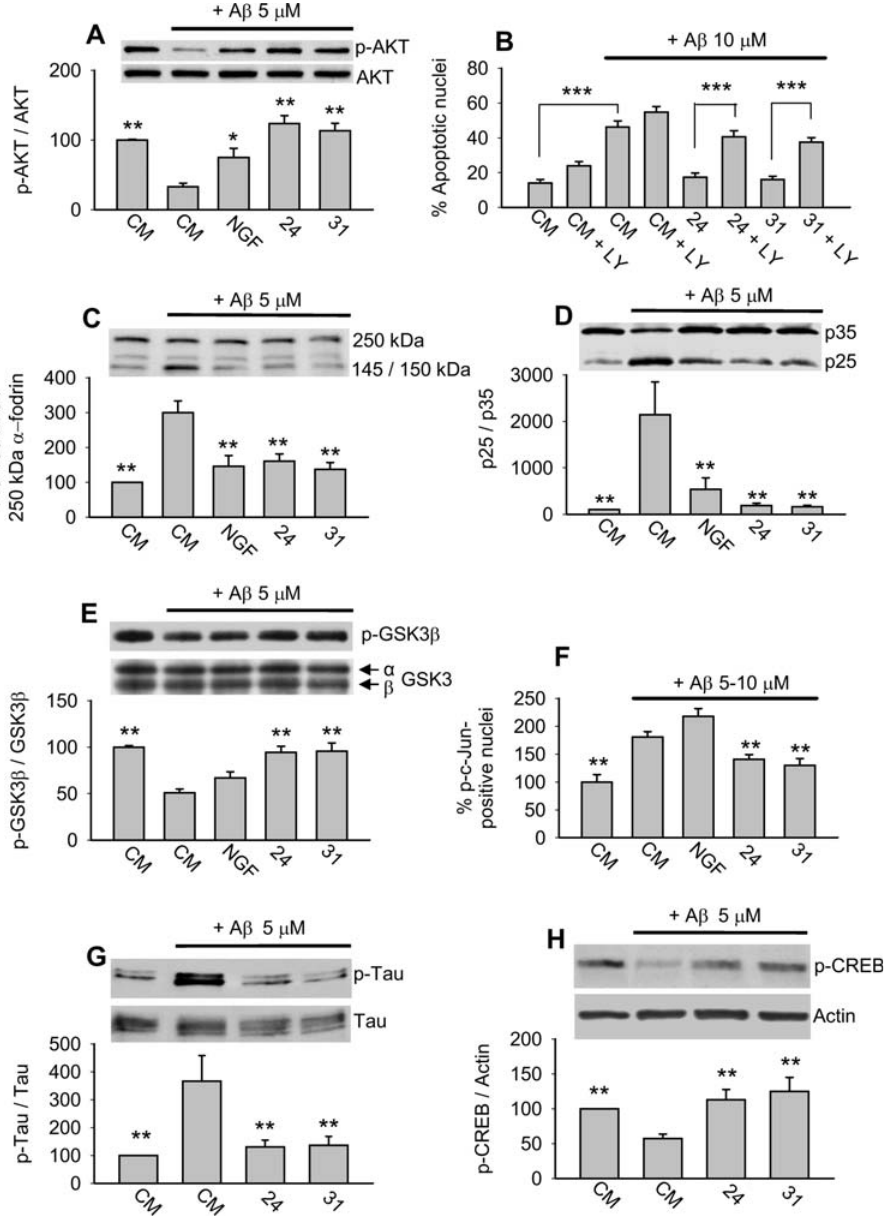
Figure 5. Modulation of A b -induced deleterious signaling. For each study, LM11A-24 and -31 were present at 100 nM and NGF at 50 or 100 ng/ml. All conditions were compared to A b treatment alone, unless indicated otherwise (e.g. Fig. 5B ). For the majority of protein preparations, each derived from separate experiments; two independent Western analyses were conducted. (A) DIV 21–22 hippocampal neurons were treated with CM alone, CM + A b , or A b in the presence of LM11A-24, -31 or NGF and examined at the 4 hour time point. AKT activation was significantly decreased by A b , while LM11A-24, -31 and NGF prevented this decrease. The ability of NGF to prevent A b -induced AKT inhibition was diminished relative to that of the small molecules (n=8–14 separate Western blots from 9 independent protein preparations). (B) Neurons were treated with CM alone or with the indicated combinations of the PI3K inhibitor LY294002, A b and LM11A-24 or -31. After 72 hours, cultures were stained with Hoechst 33258 for cell death quantitation. In CM, LY294002 increased cell death by approximately 1.7-fold without reaching significance. In the presence of A b , LY294002 blocked the protective effect of p75 NTR ligands and resulted in a . 2.0-fold increase in cell death (n=35–45 fields derived from a total of 4–5 experiments for each condition). (C–E) DIV 21–22 hippocampal neurons were treated with CM or A b in the presence of LM11A-24, -31 or NGF for 4 hours. (C) Addition of A b resulted in increased calpain-induced cleavage of full-length a -fodrin (250 kDa) to its 150 and 145 kDa fragments. Co- treatment with LM11A-24, -31 or NGF, significantly reduced A b -induced calpain activation (n=4–7 separate Western blots from 4 independent protein preparations). (D) Addition of A b induced cdk5 activity as revealed by the increased ratio of the cleaved (p25) to uncleaved (p35) regulatory subunit. Activation was inhibited by LM11A-24, -31 or NGF (n=8–10 separate Western blots from 7 independent protein preparations). (E) Addition of A b induced GSK3 b activation as revealed by a decrease in the ratio of p-GSK3 b Ser9 signal to total GSK3 b . Activation was significantly inhibited by LM11A-24 and 31, but not NGF (n=8–14 separate Western blots from 7 independent protein preparations). (F) In DIV 6–7 neuronal cultures examined at the 12 hour time point, A b induced a 1.8-fold increase in the proportion of phospho-c-Jun positive nuclei, a measure of JNK/c-Jun activation. Activation was significantly inhibited by LM11A-24 and 31, but not NGF (n=139–210 fields from 6 individual experiments). (G) In DIV 21– 22 hippocampal neuronal cultures examined at the 4 hour time point, A b induced a 3.5-fold increase in Tau Ser202 phosphorylation which was